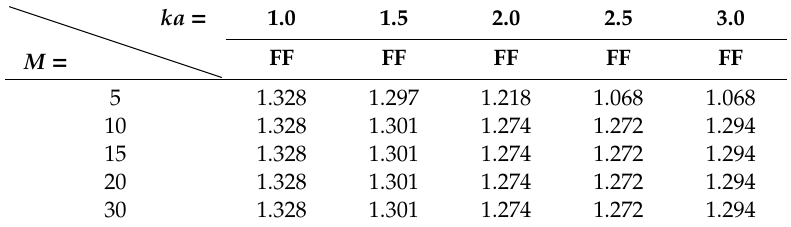
Table 3. Variation of the normalized mean drift wave force component involved in the far-field formulation, f − , with respect to M ( d = 3 a , b = 2 a , and G 0 = 0.1). f